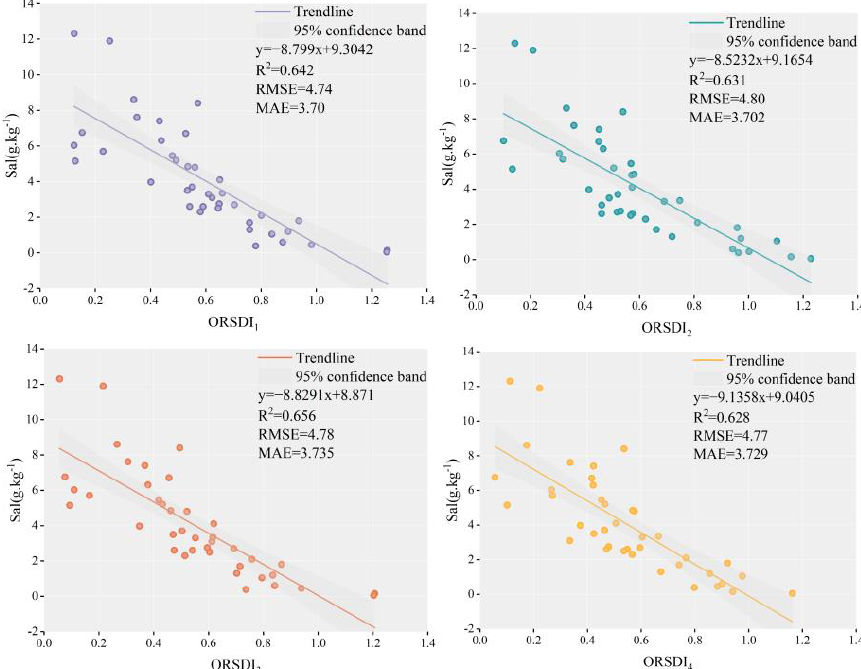
Figure 13. Correlation analysis between the model inversion results and measured data.